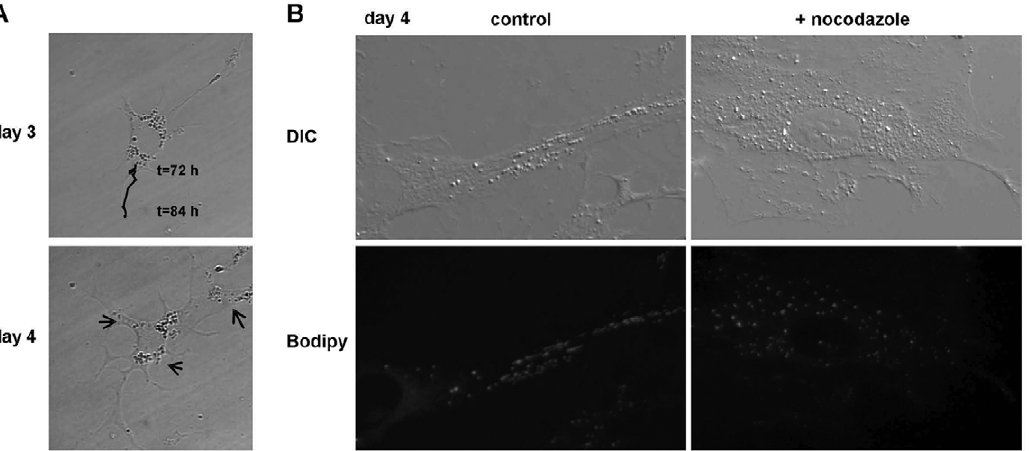
Figure 2. LD redistribution during HSC activation is microtubule dependent. A. Frames from time lapse life cell analysis revealing redistribution of dynamic LDs towards growing cellular extensions. Tracking shows the typical movements of a dynamic LD from 72 h to 84 h of HSC activation. Arrows indicate other regions of dynamic LDs (trackings not shown). B. To examine microtubule involvement in the LD redistribution process, freshly isolated HSCs were after 24 h in culture either treated with 10 m M nocodazole or vehicle (control) for 72 h at 37 u C and after fixation, morphology and LD localization were analyzed by differential interference contrast microscopy (DIC) and fluorescence microscopy after Bodipy staining.